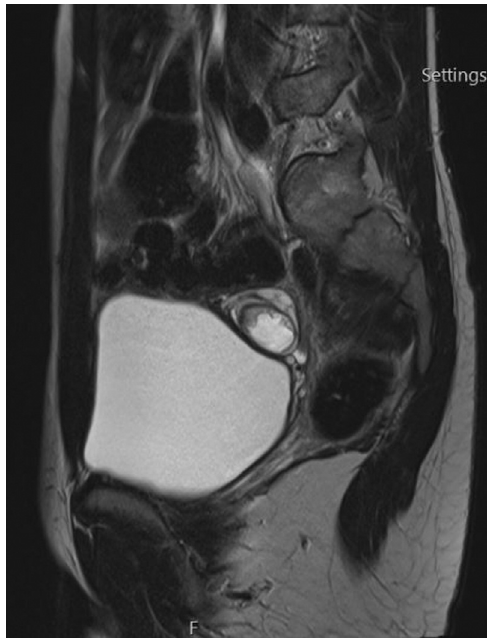
Fig. 4 Magnetic resonance imaging (MRI) demonstrating a sagittal view of the metachronous left ovarian teratoma